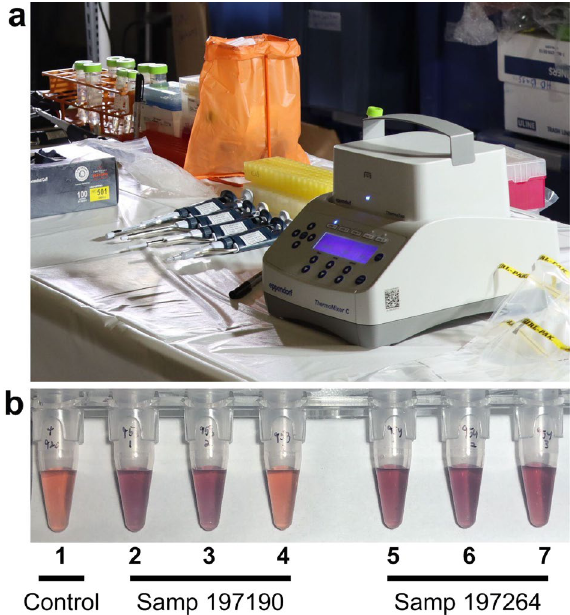
Figure 5. Images from experiments performed in the field. ( a ) Portable MN-QuIC setup used during field deployment. ( b ) Example of observed visible color of the MN-QuIC reaction when testing for CWD. Far-left tube (Tube 1) is a positive control, followed by CWD not-detected tube (in purple; Tubes 2, 3, 5, 6, 7) and a single CWD positive tube (in red; Tube 4). Tubes 2–4 correspond to animal 197190 in Table S2 and tubes 5–7 correspond to animal 197264 in Table